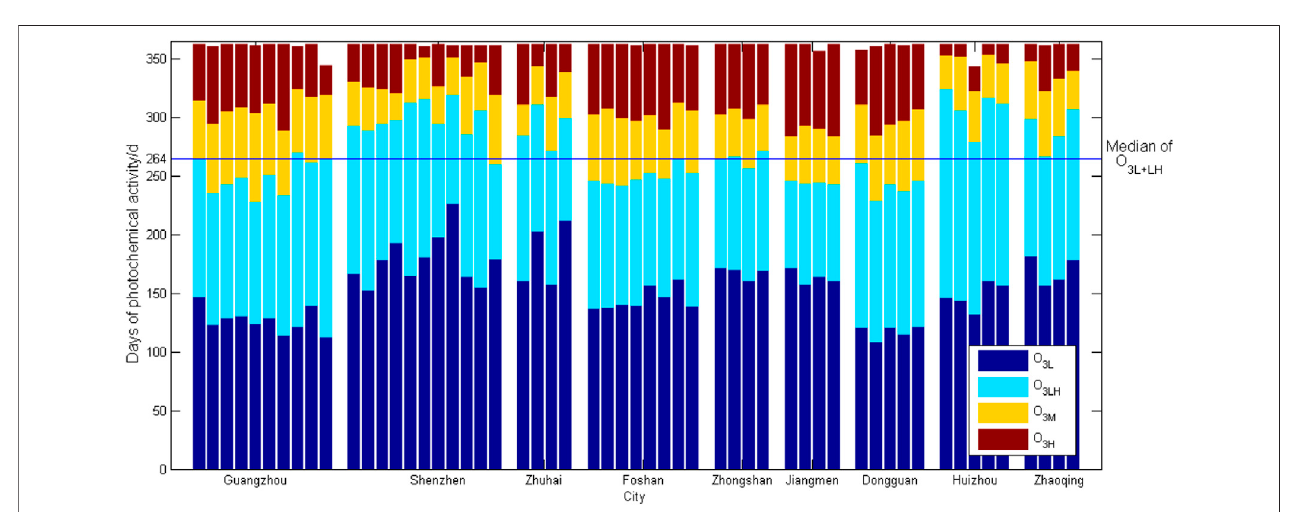
FIGURE 5 | Daily distribution of photochemical activities in the